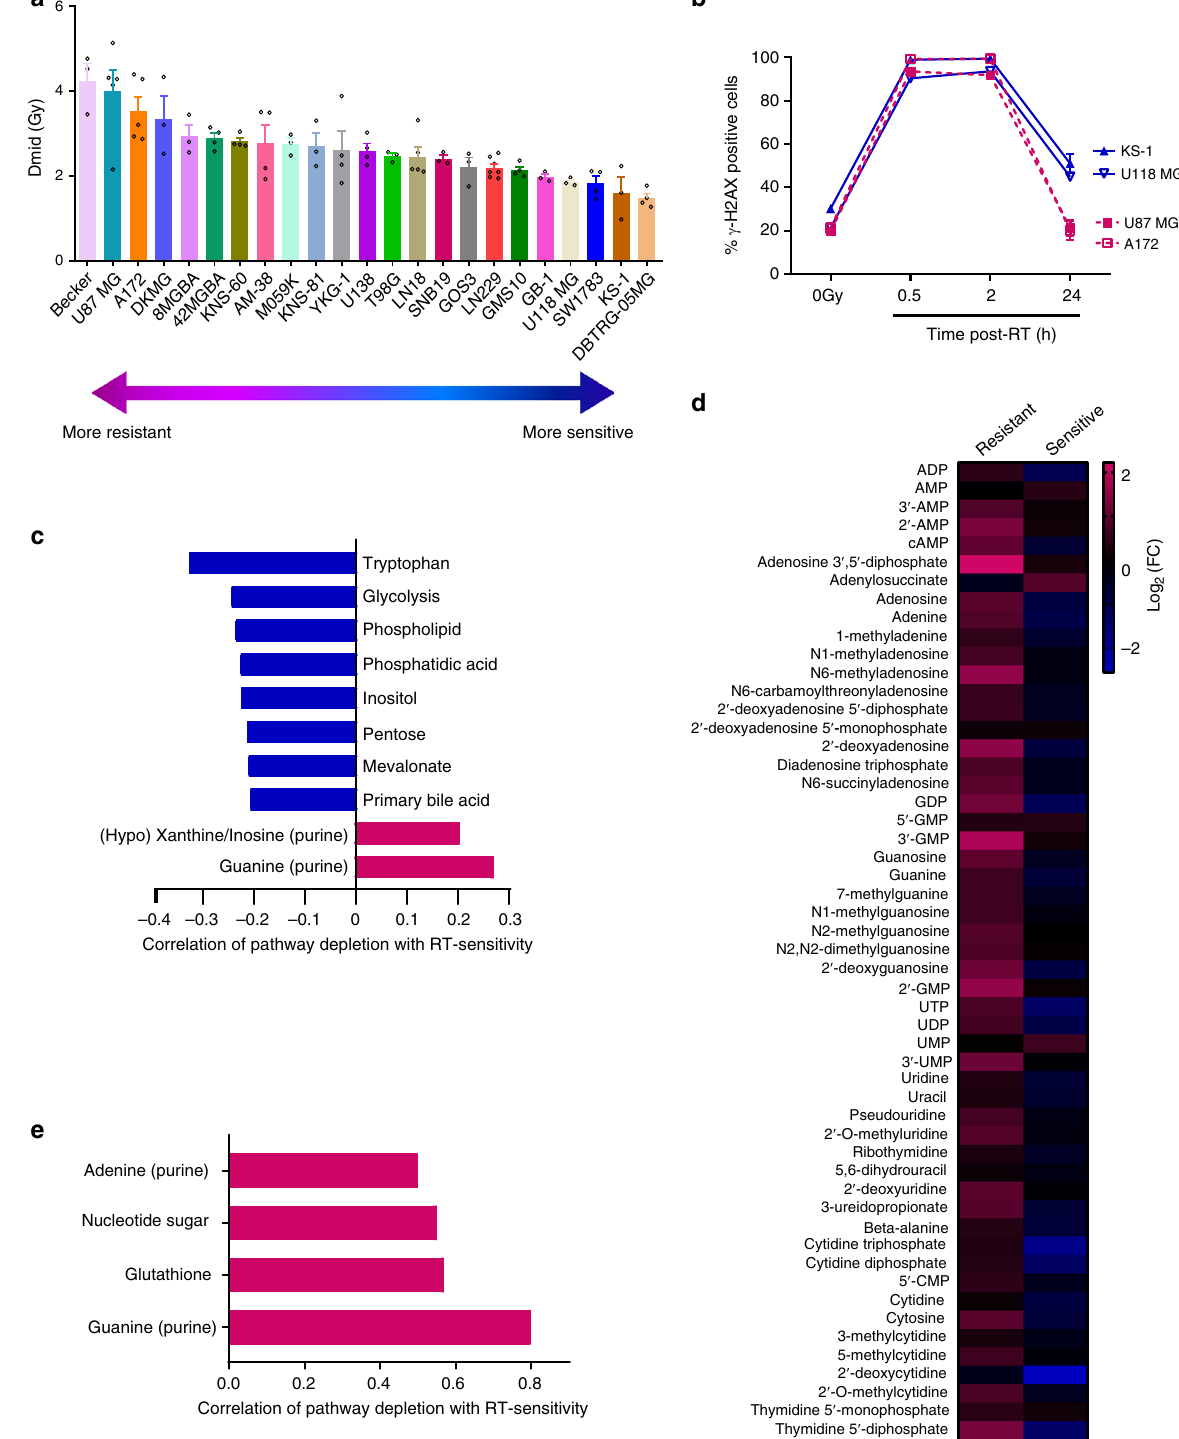
nucleobase-containing metabolites and RT-resistance in GBM was causal. Nucleotide-poor RT-sensitive GBM cell lines were supplemented with cell-permeable nucleosides (cytidine, guano- sine, uridine, guanosine, and thymidine at concentrations 80 – 240 μ M) and RT-sensitivity was determined by clonogenic assay (Fig. 2a). RT-sensitive GBM cell lines (U118 MG, DBTRG-05MG,